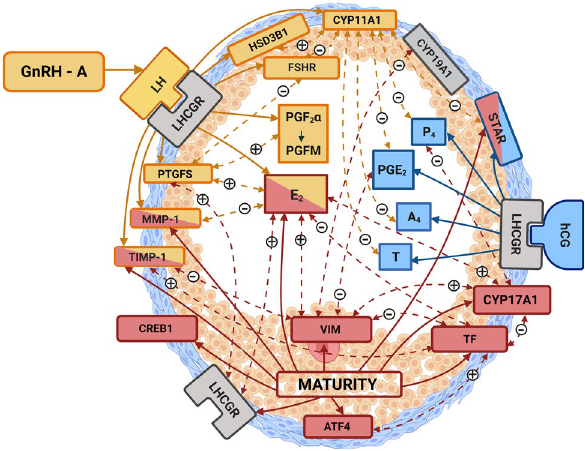
Figure 8. Illustrative summary of two ovulation stimuli: hCG, GnRH-A and the sexual maturity status (prepuberty or maturity; MATURITY) effects on endocrine milieu of the preovulatory ovarian follicle in gilts. HCG directly (blue solid arrows) affects STAR protein expression and steroid hormones (P 4 , A 4 , T) and PGE 2 production. GnRH-A causes release of endogenous LH that after activation of LH/hCG receptor (LHCGR) affects (yellow solid arrows) HSD3B1, CYP11A1, FSH receptor (FSHR), PTGFS protein expression, estradiol (E 2 ), prostaglandin F 2α (PGF 2α ) concentration in follicular fluid, matrix metalloproteinase (MMP-1) and its inhibitor (TIMP-1) proteins. MATURITY directly (red solid arrows) affects steroidogenic enzymes (STAR, CYP17A1) and LHCGR proteins, E 2 concentration, transcription factors CREB1 and APF4 proteins, local regulators of steroidogenesis vimentin (VIM), transferrin (TF) and MMP-1, TIMP-1 proteins. The positive ( +) or negative (-) correlations between studied proteins and/or hormones are showed (double – faced dotted